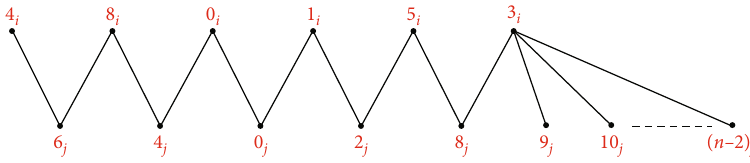
1, 0, 0, 0, 0, 0, 0, 0, 0, n − 10 ÞÞ i , j 10 ð